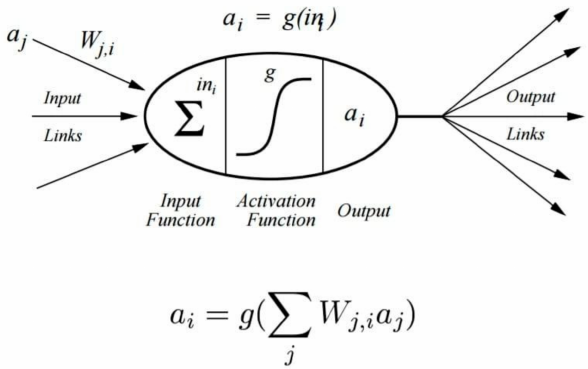
Figure 2. Basic Neural Model. Legend: ( g ) means Activation Function: Determines whether or not the perceptron “reacts to input